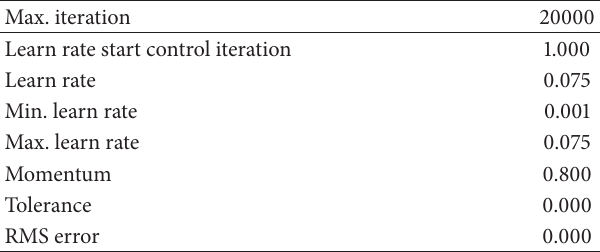
Table 3: Training parameters for all